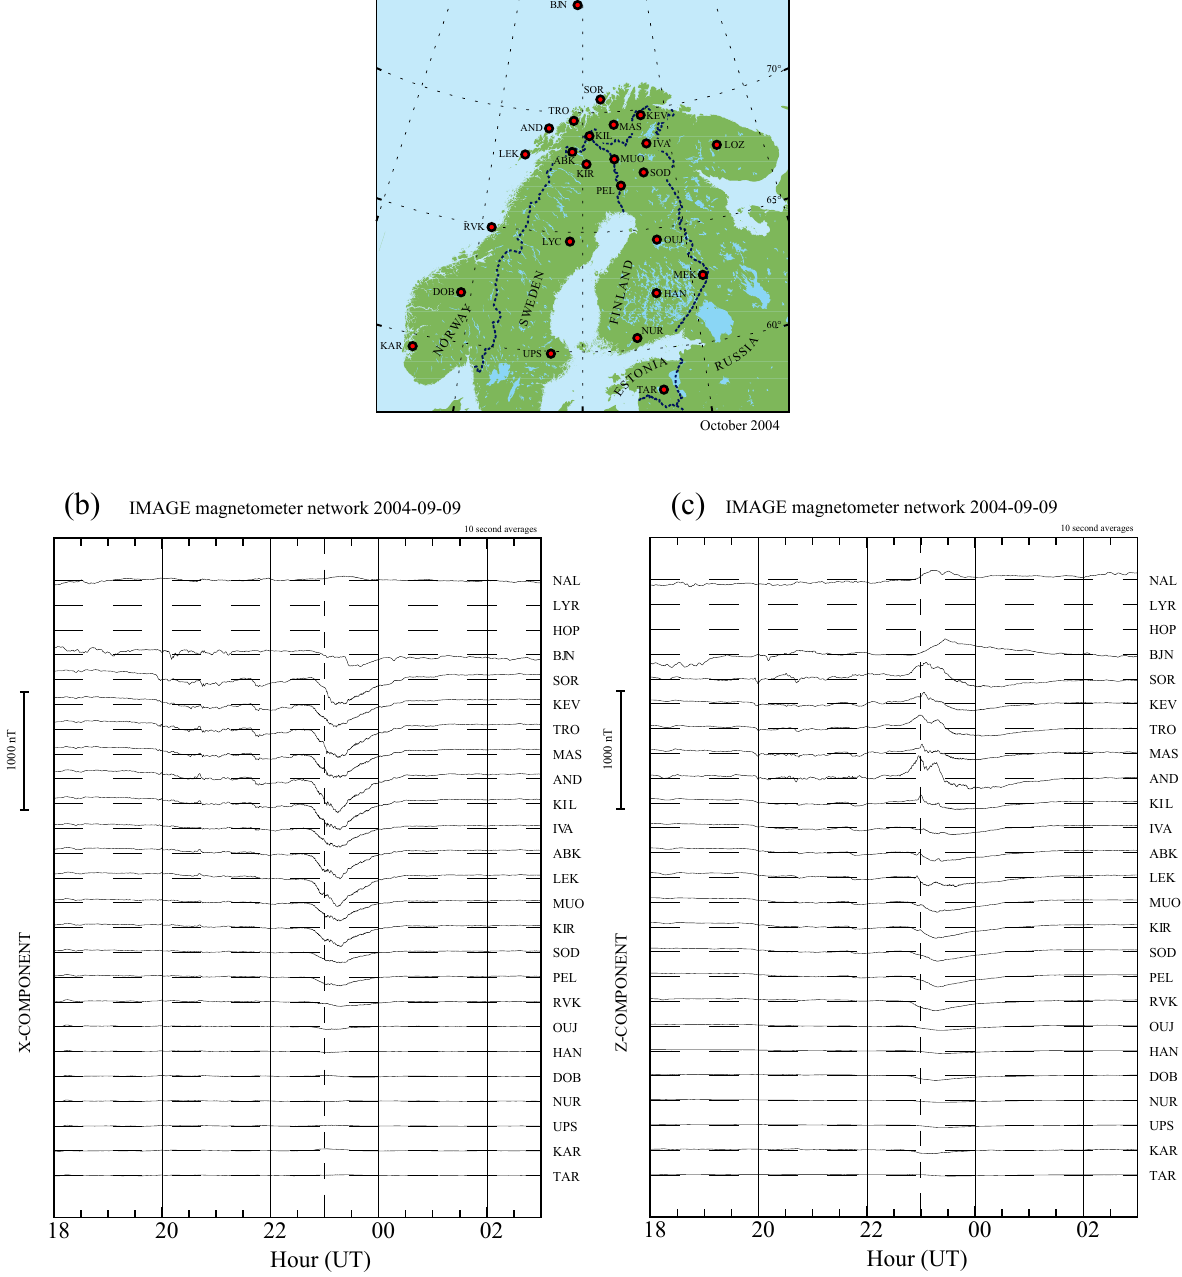
Fig. 3. (a) Map of the IMAGE magnetometer stations in northern Scandinavia. Temporal variations in (b) x-component and (c) z-component of the geomagnetic field measured from 18:00UT on 9 September to 03:00UT on 10 September 2004 using the IMAGE magnetometer chain. These figures are prepared using 10-s averaged data. Vertical dashed line marks 23:00UT on 9 September 2004. These figures